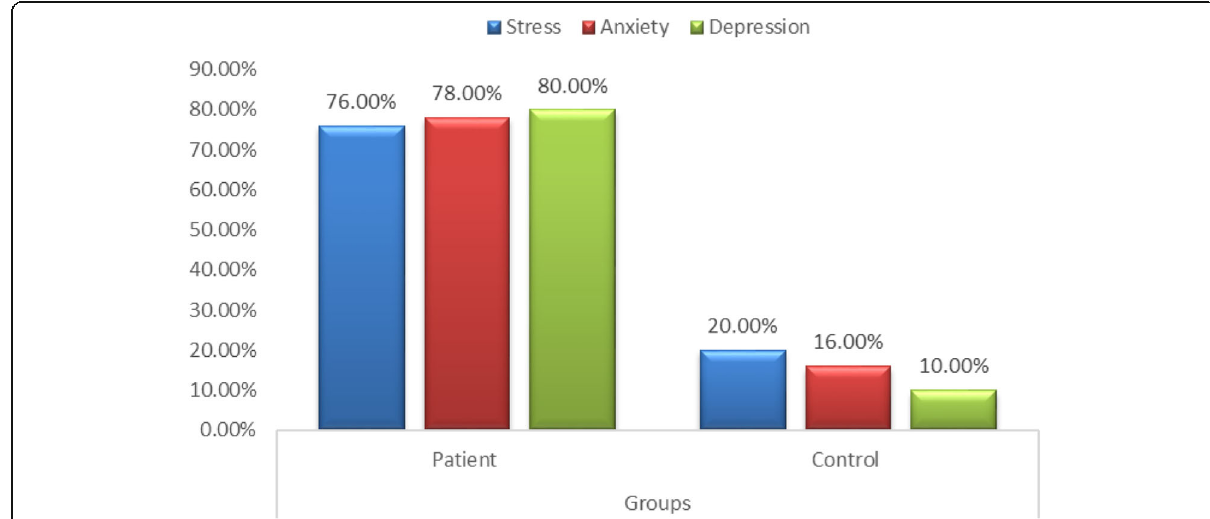
Fig. 4 Comparison between groups regarding stress, anxiety, depression